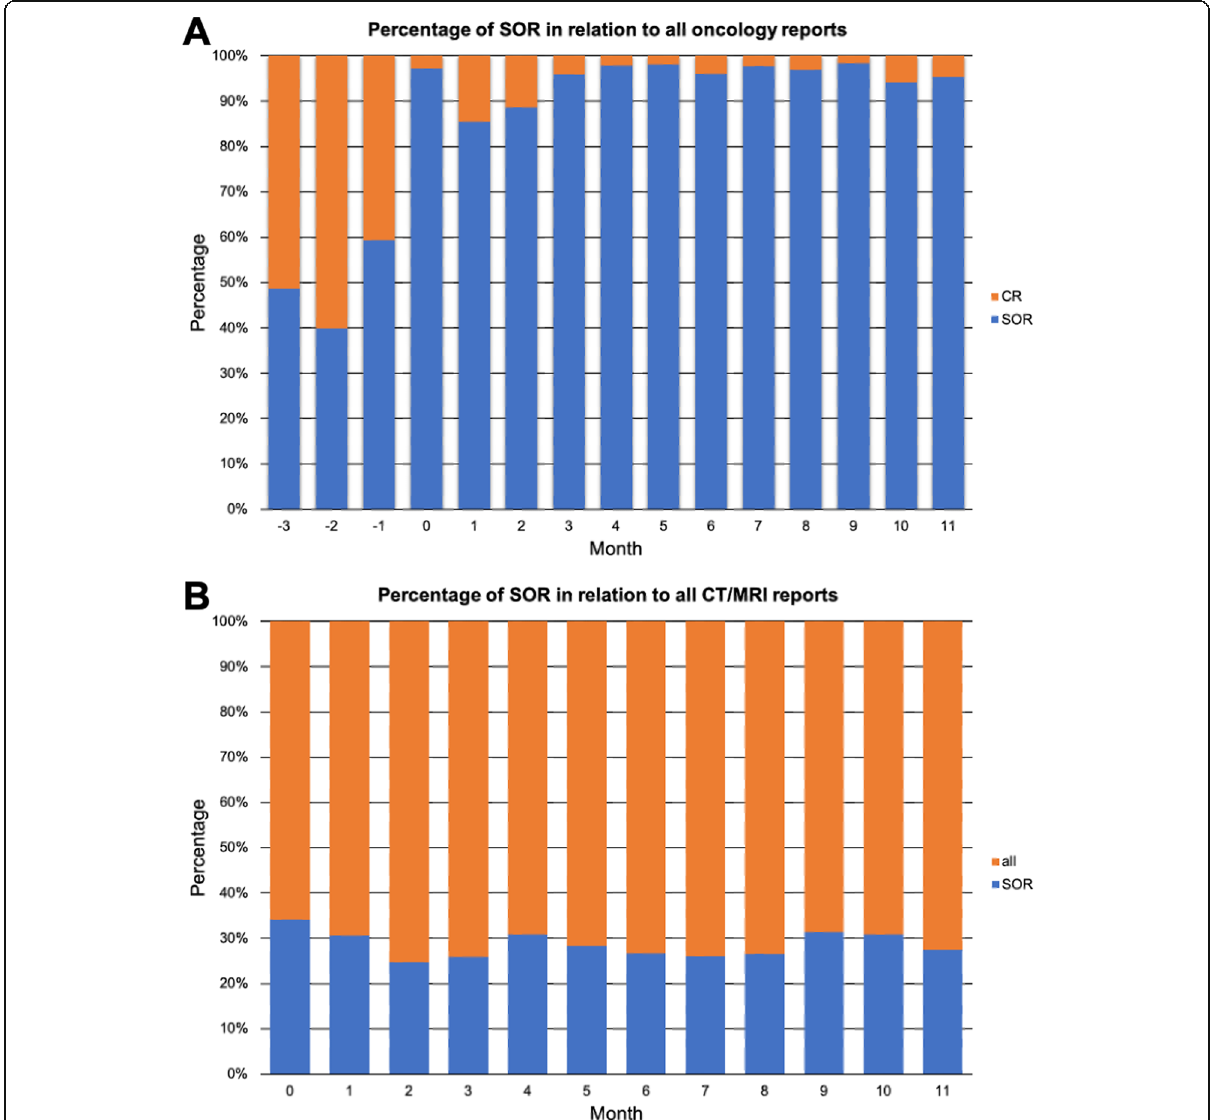
Fig. 3 Percentage of structured oncology reports used for oncological follow-up imaging. a The proportion of SOR to all reports generated for a representative division of the department for medical oncology. b The proportion of SOR to all reports generated for scans at the CT and MRI scanners used for body imaging. Month 0 indicates time point of department-wide roll out of structured oncology reports. SOR, structured oncology report; CR, conventional